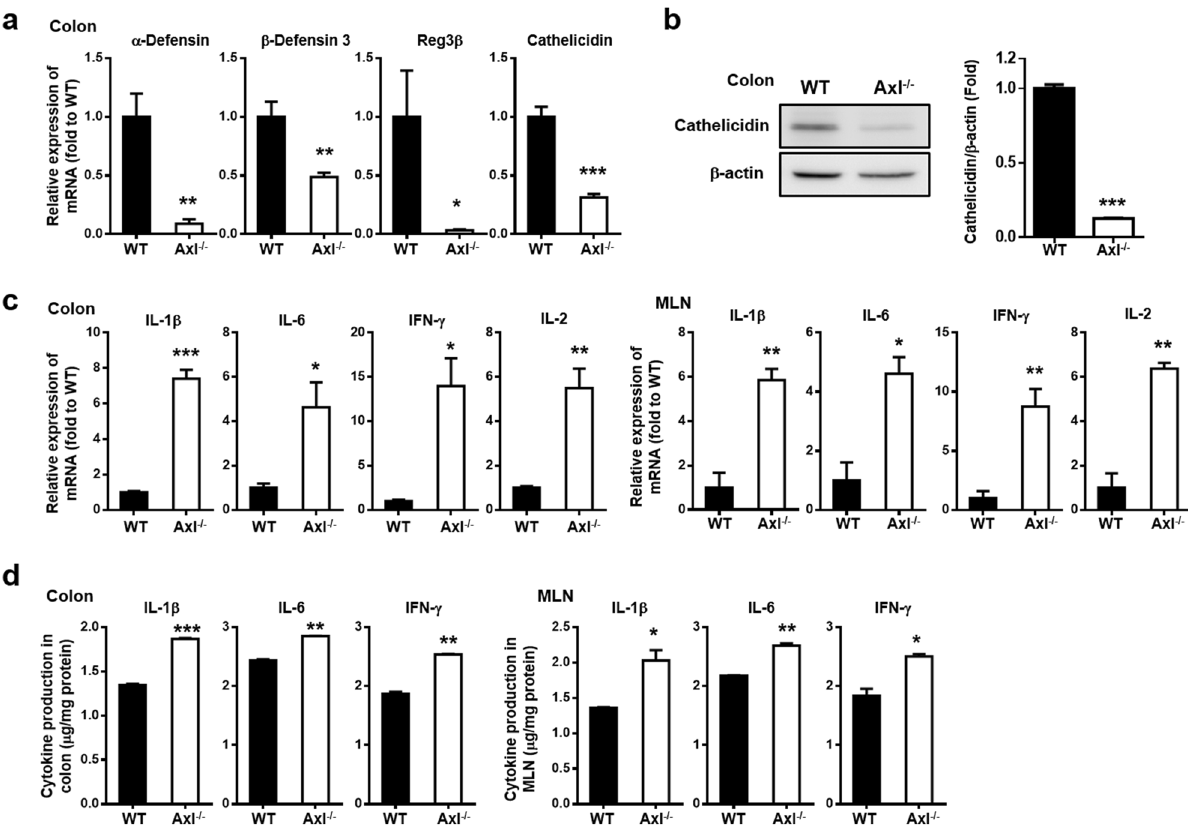
Figure 4. A deficiency of Axl reduced AMPs and increased proinflammatory cytokine expression. ( a ) mRNA expression of AMPs was analyzed by qRT-PCR in the colon of WT and Axl −/− mice. ( b ) Protein expression of cathelicidin was analyzed by western blot in the colon. ( c ) mRNA expression of inflammatory cytokines was analyzed by qRT-PCR in the colon and MLN. ( d ) Protein levels of IL-1β, IL-6 and IFN-γ were determined by ELISA in the colon and MLN. Data are shown as mean ± SEM. Significance (*p < 0.05, **p < 0.01, ***p < 0.001) was compared with WT mice and calculated by the Student’s